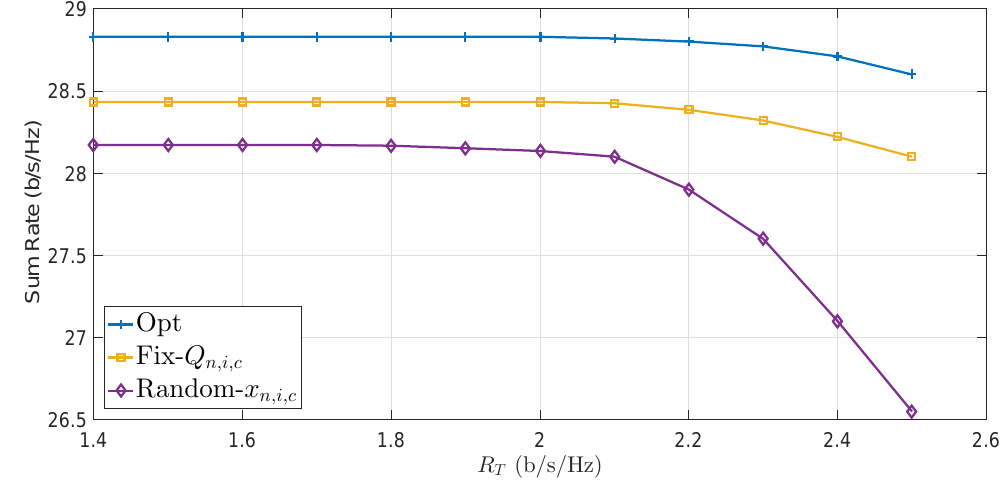
Figure 6. Impact of increasing R T on the sum rate of the